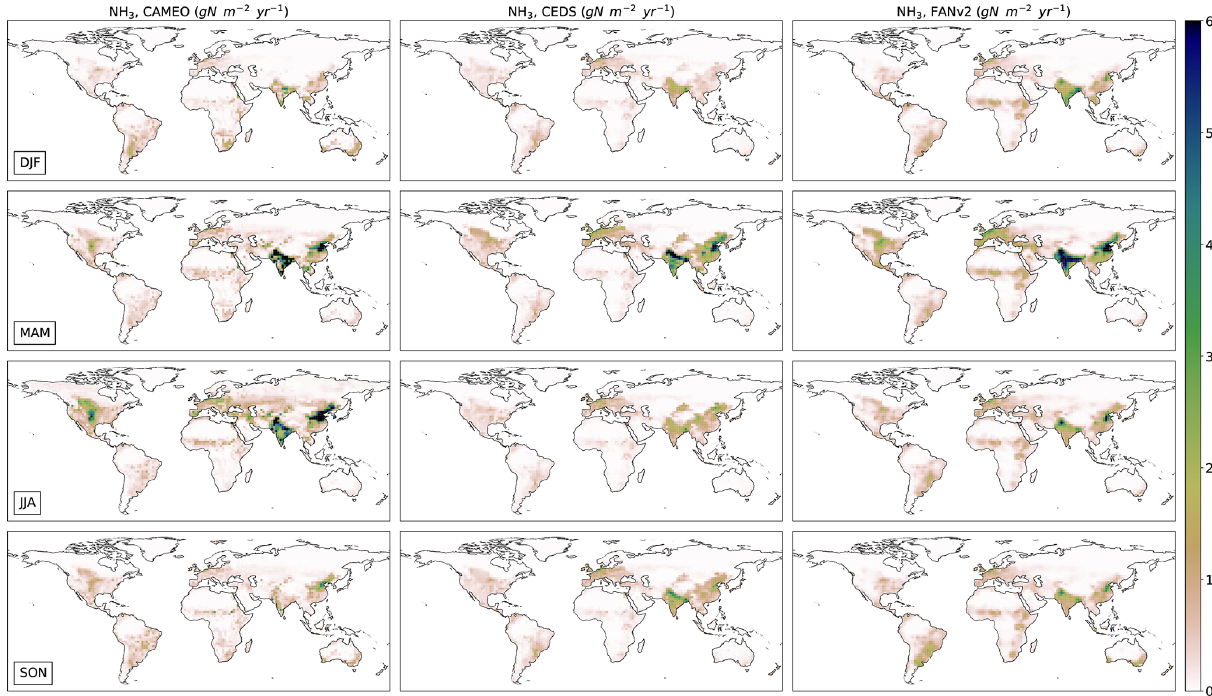
Figure 11. Seasonal patterns of ammonia emissions (gNm − 2 yr − 1 ) from total agricultural sources simulated by CAMEO (2005–2015 average, first column), estimated in the CEDS inventory (2005–2015 average, second column), and simulated by the FANv2 model (2010– 2015 average, third